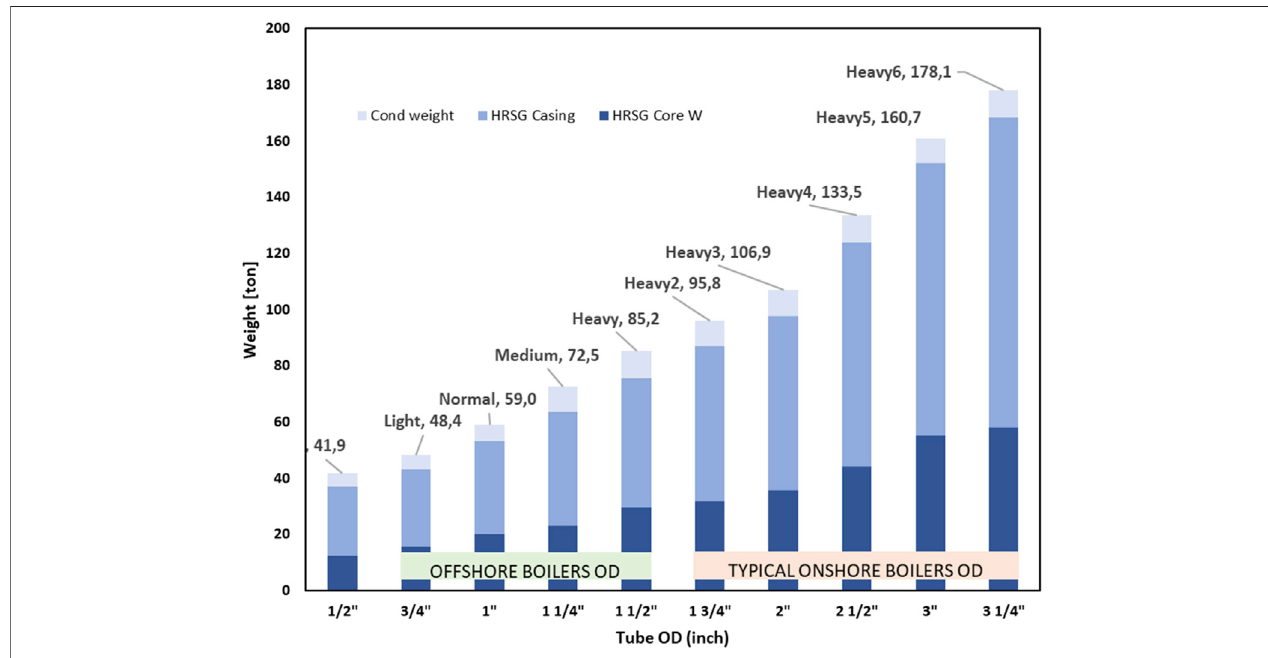
FIGURE 5 | Weight of heat exchangers (OTSG 1 + OTSG 2) and condenser (cond) for optimal minimum weight designs based the tubes in Table 3 . The results show 10 designs from “ very-light ” design; four designs sensible for off-shore boilers and fi ve designs with OD for onshore boilers, and weight distribution between condenser weight, and OTSG casings and cores.